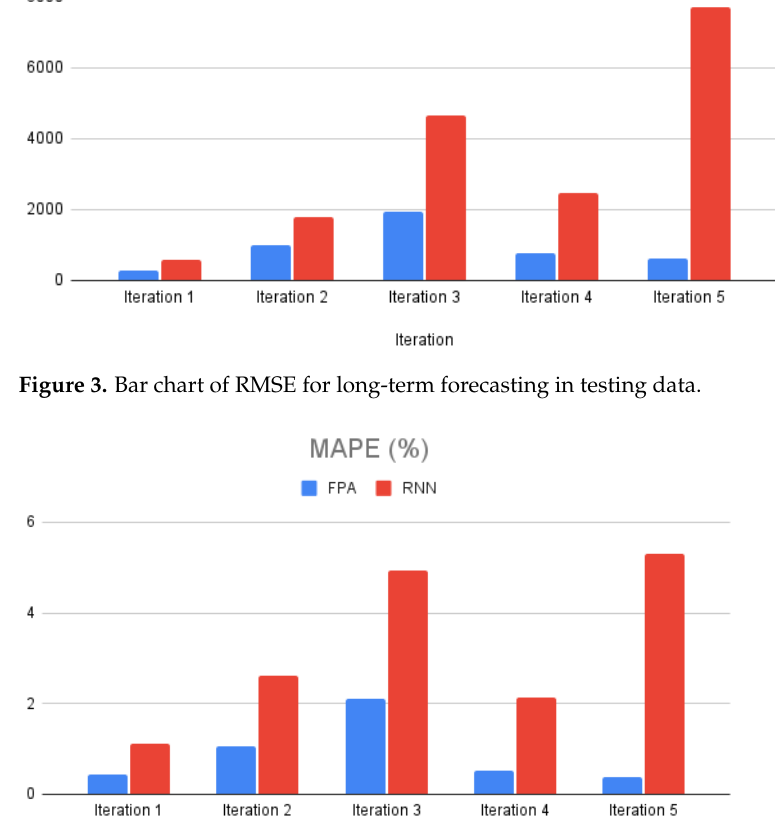
Figure 4. Bar chart of MAPE for long-term forecasting in testing data.